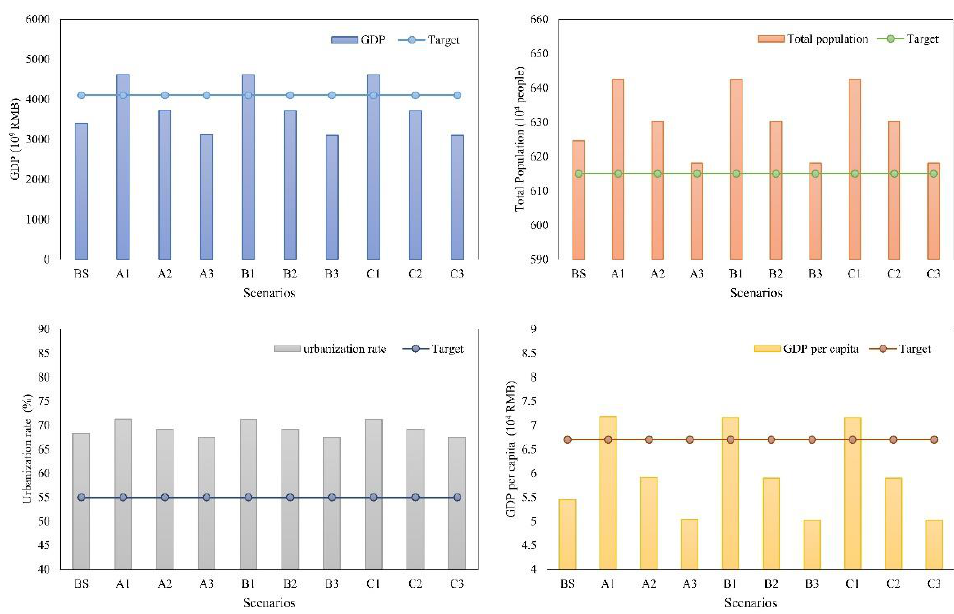
Figure 7. Development target in 2030 and simulation results of different scenarios.